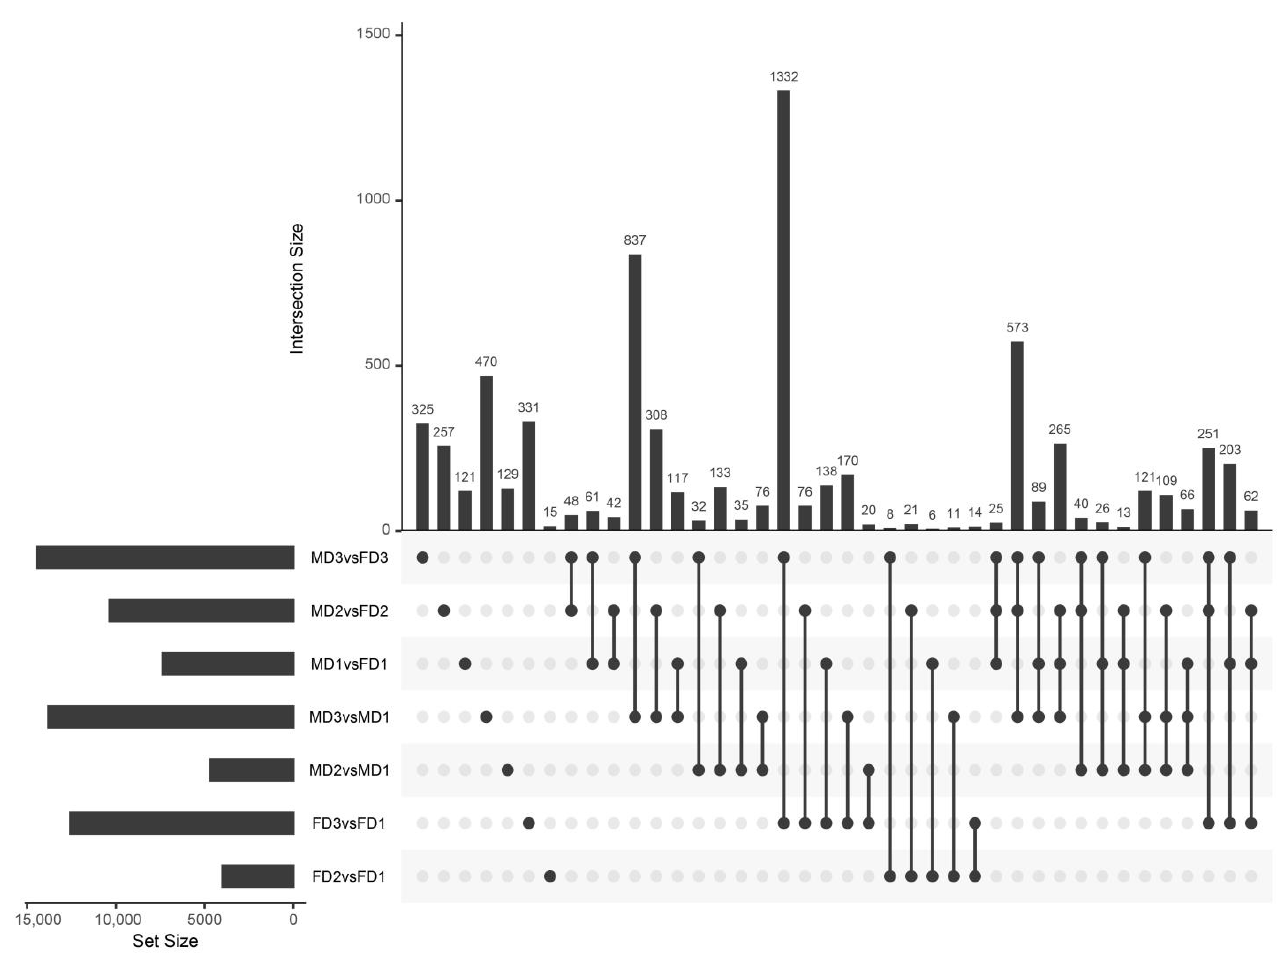
Figure 3. Overlap of differentially expressed genes between all comparisons. The horizontal and vertical bars of the UpSetR [35] plot indicate the number of differentially expressed genes in each comparison and the size of the gene set determined by only one comparison and intersection, respectively. Single nodes and corresponding horizontal bars represent the number of unique genes for this dataset and are not shared between other comparisons.